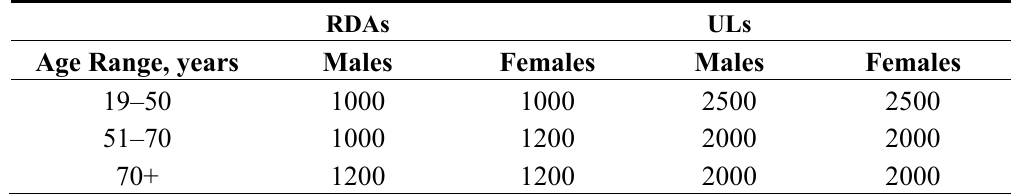
Table 1. Adult Recommended Dietary Allowances (RDAs) and Tolerable Upper Intake Levels (ULs) for Calcium: mg per day